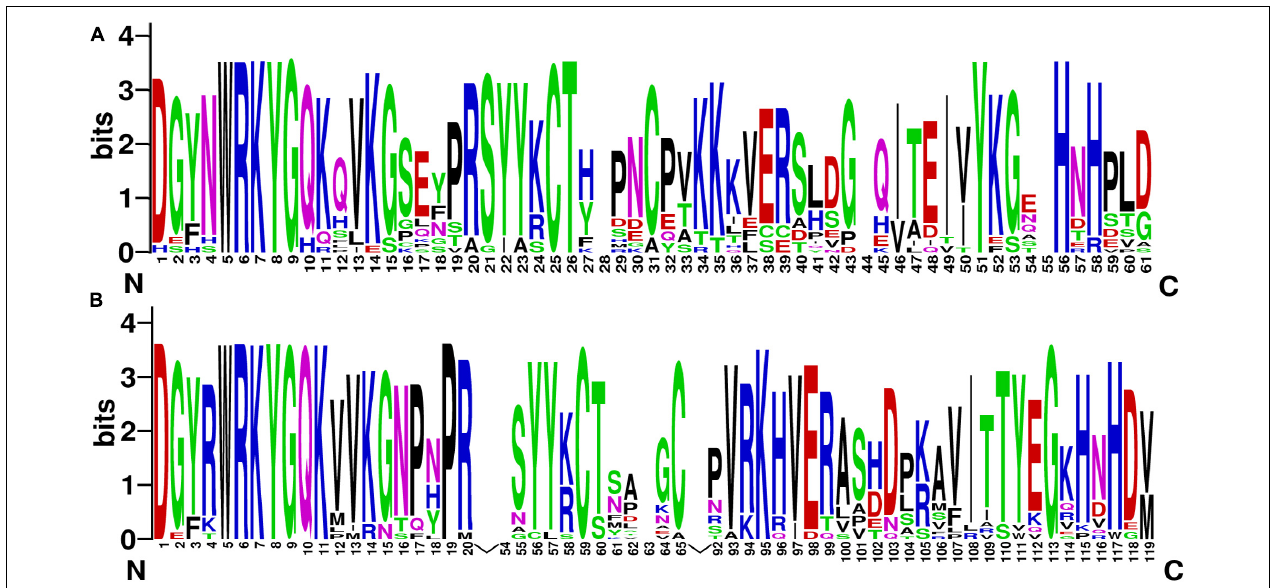
FIGURE 1 | The sequence logos of the first WRKY domain (A) and the second WRKY domain (B) . These logos were based on multiple alignments of all WRKY proteins. The bit score indicates the information content for each position in the